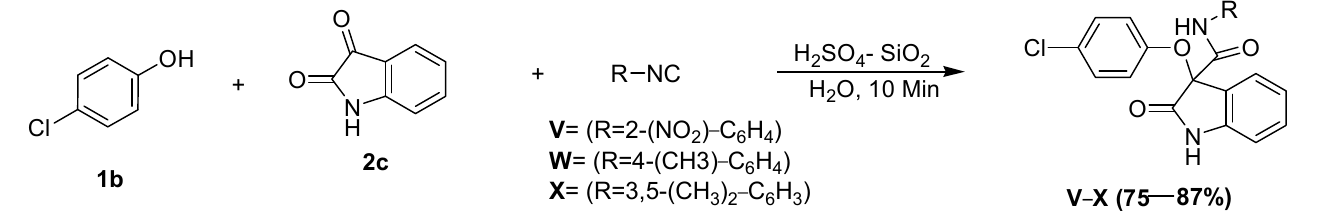
Scheme 5. Passerini reaction in aqueous media, employing 4-chlorophenol as the acid surrogate